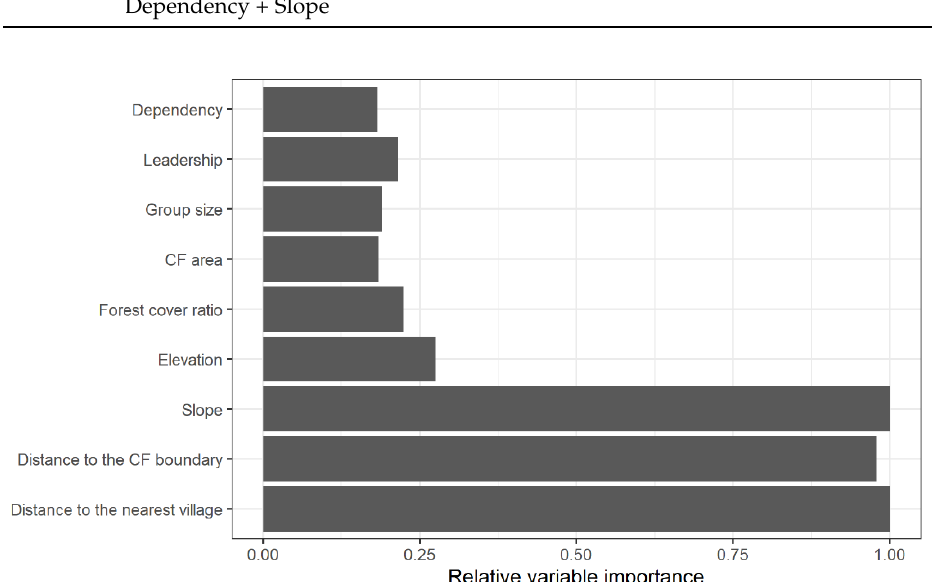
Figure 2. Relative importance of independent variables.